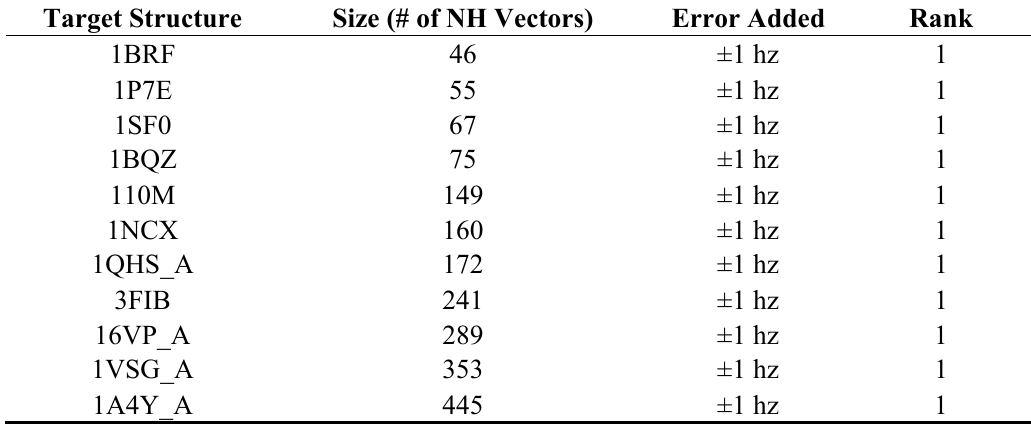
Table 1. Results of structure identification using simulated